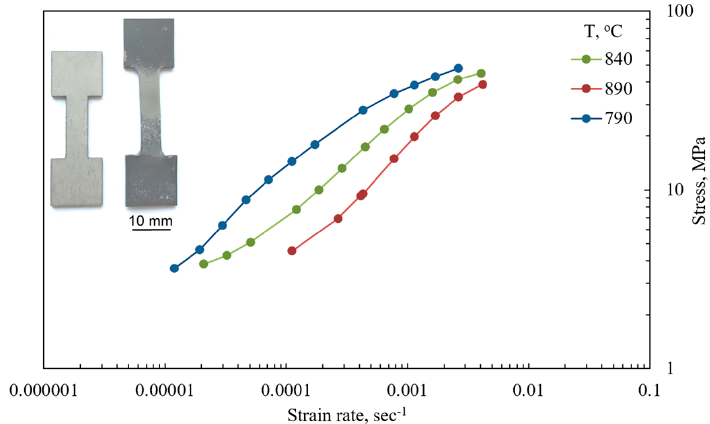
Figure 1. The results of the tests at different temperatures.